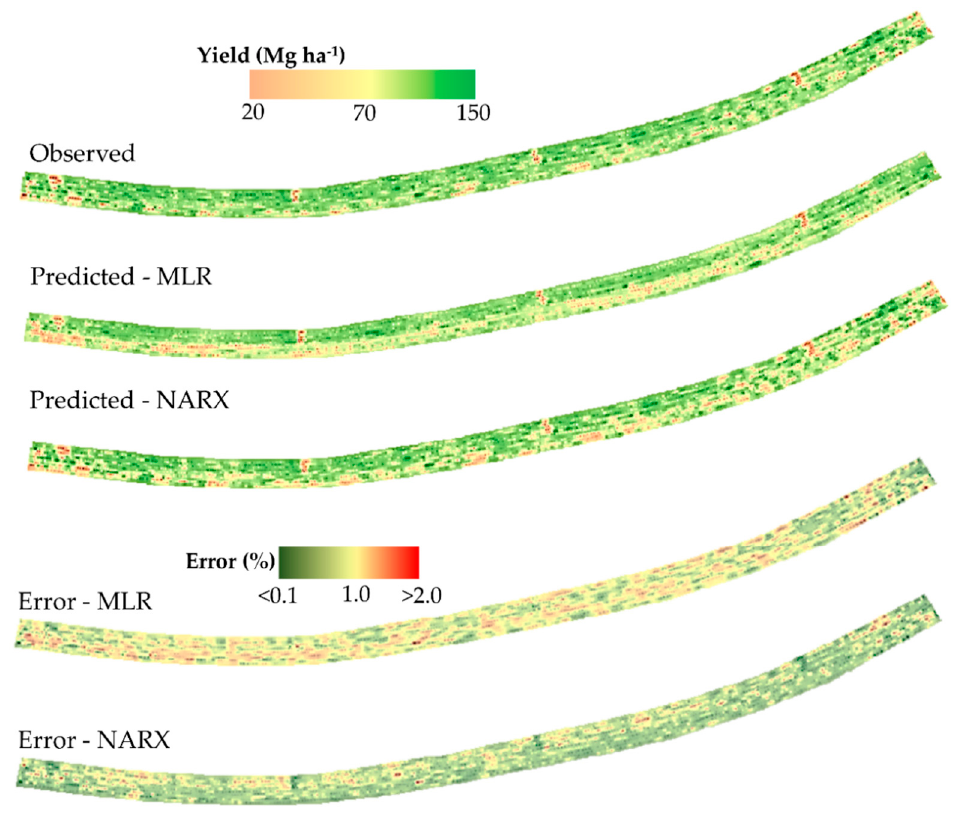
Figure 6. Yield map of the observed data predicted by multiple linear regression (MLR) and nonlinear autoregressive networks with exogenous input (NARX). Below the yield map contains the prediction error (%), spatialized.